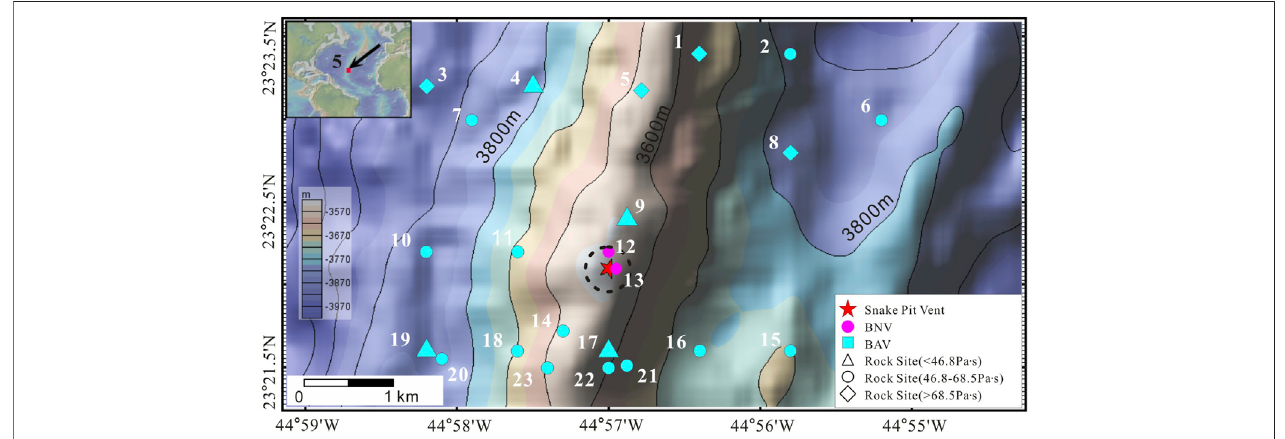
FIGURE 4 | Bathymetric map from GeoMapApp, showing the location of the Snake Pit vent and the sample sites. The dashed circle encloses the range of BNV. Black solid lines are the 10 m isobaths. The symbols and color bar are described in the caption of Figure 3 .